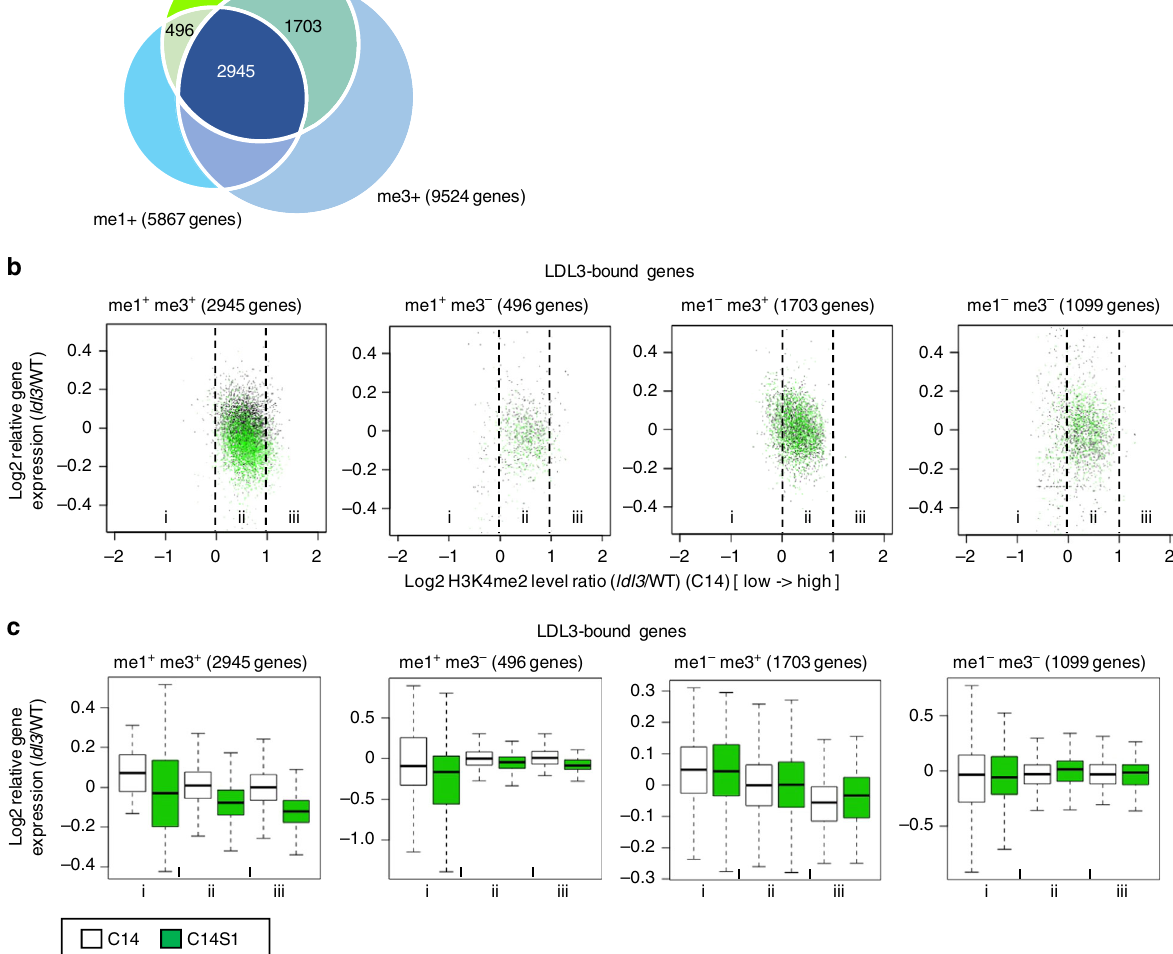
Fig. 6 LDL3-mediated H3K4me2, in cooperation with other H3K4me marks, regulates gene expression. a Venn diagram of LDL3-bound genes with or without either H3K4me1 or H3K4me3 in wild-type callus (C14). LDL3-bound genes were classi fi ed into four groups according to the presence or absence of high level of H3K4me1 or H3K4me3 (> 20 RPKM). 2945 genes (47.2%) of LDL3-bound genes were found on me1 + me3 + genes. b Altered gene expression in ldl3 before (C14, black dots) and after (C14S1, green dots) shoot induction with reference to hyper H3K4me2 caused by ldl3 in LDL3-bound genes included in four gene sets, assorted by H3K4me1 and H3K4me3 states. c Based on the changes of H3K4me2 between WT and ldl3 [Log2 (RPKM_ ldl3 /WT)] at C14 in ( b ), each set of LDL3-bound genes was divided into three groups ( i <0, 0< ii <1, iii >1). Gene expression fold-changes between WT and ldl3 [Log2 (RPKM_ ldl3